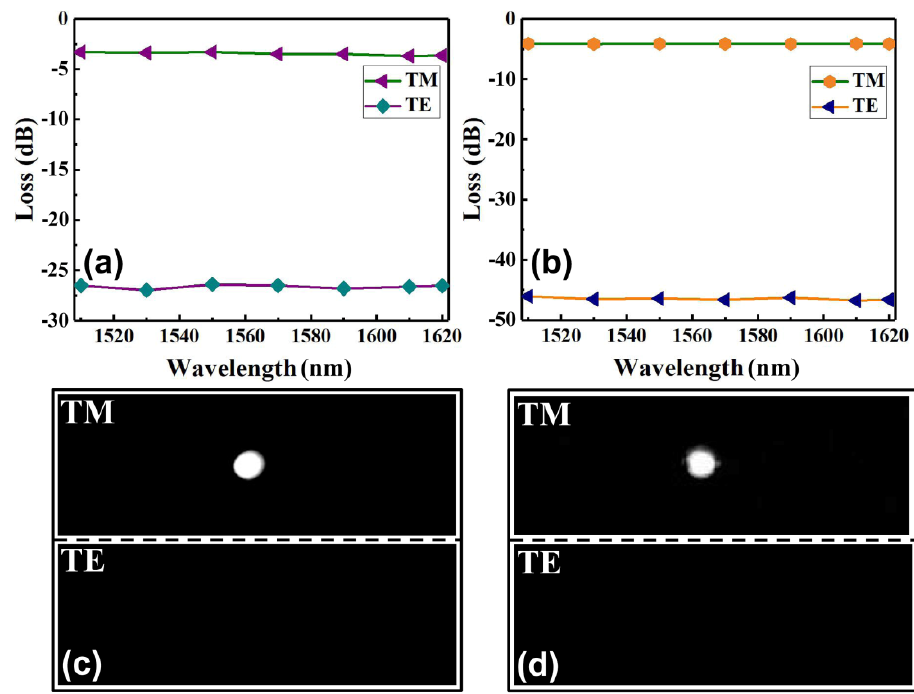
Figure 7. The insertion losses measured for ( a ) Structure 1 with a graphene film length of 3.6 mm and ( b ) Structure 2 with a graphene film length of 3 mm; the output near-field images taken at TM and TE polarization, respectively, for ( c ) Structure 1 and ( d ) Structure 2.